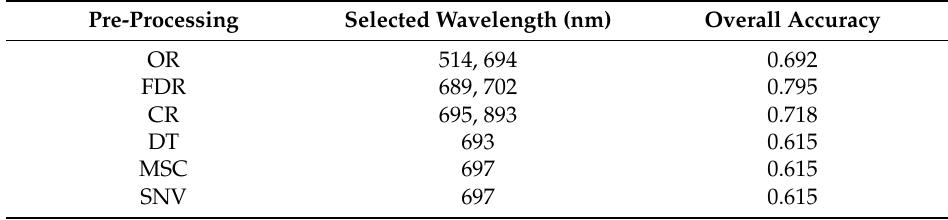
Table 3. E ff ective wavelength to distinguish the S strength based on stepwise discriminant analysis ( p <